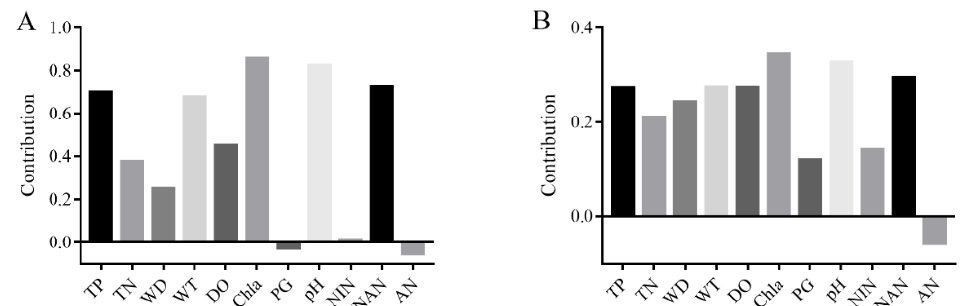
Figure A1. Contribution of physicochemical factors to the bacterial community composition ( A ) and function ( B ). Statistical analyses were performed using variance partitioning analysis.